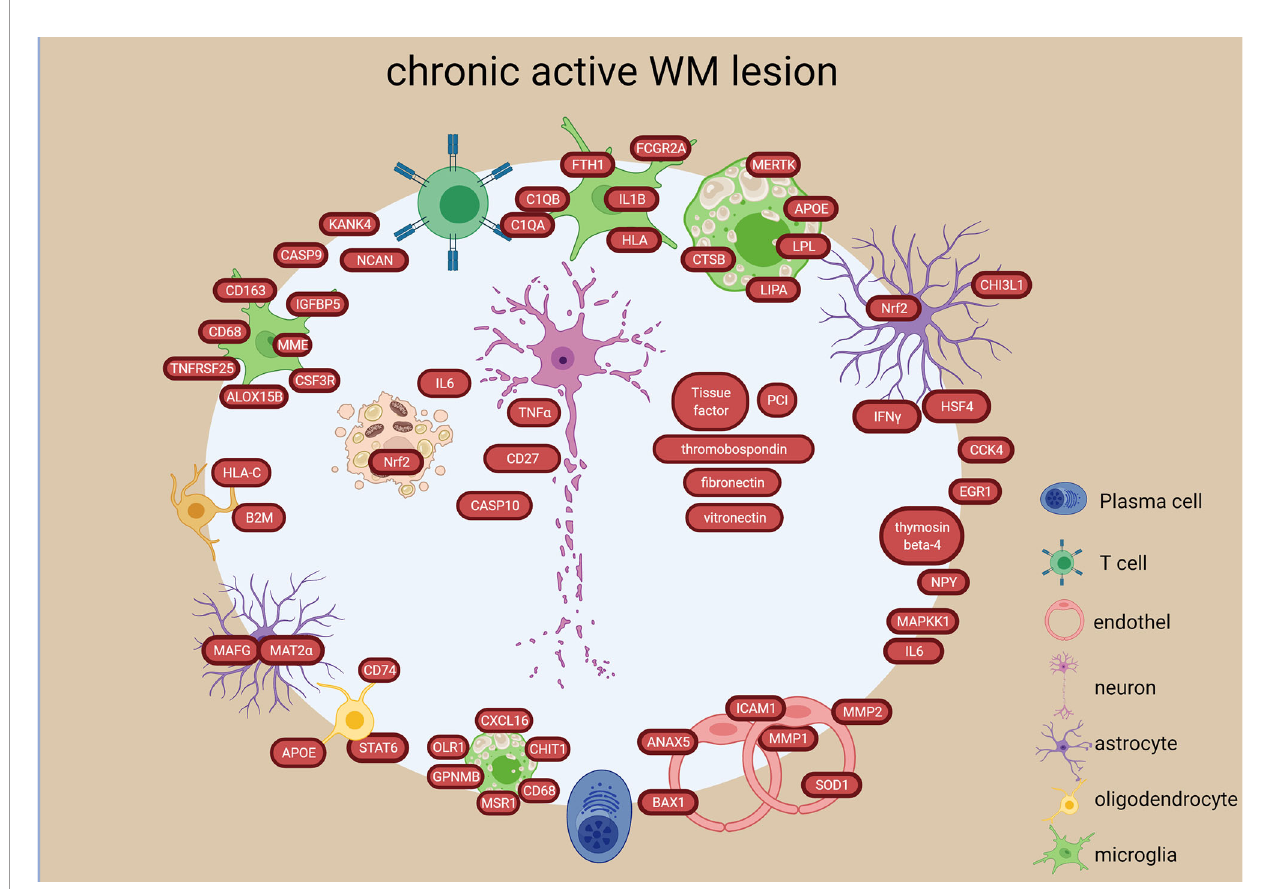
FIGURE 6 | Signatures of chronic active lesion in the WM lesion types in the MS brain based on transcriptome and proteome studies. Chronic active lesion has a different molecular pro fi le in rim vs center. Most activity is present in the rim with stressed astrocytes and oligodendroglia, proin fl ammatory microglial polarization and foamy macrophages. Additionally, presence of coagulation factors and endothelial alterations are detected. The chronic active lesion displayed the highest number of neuronal/axonal intracellular components. The fi gure was created by compiling data from several articles, and therefore molecules may not be expressed at the same time. Created with